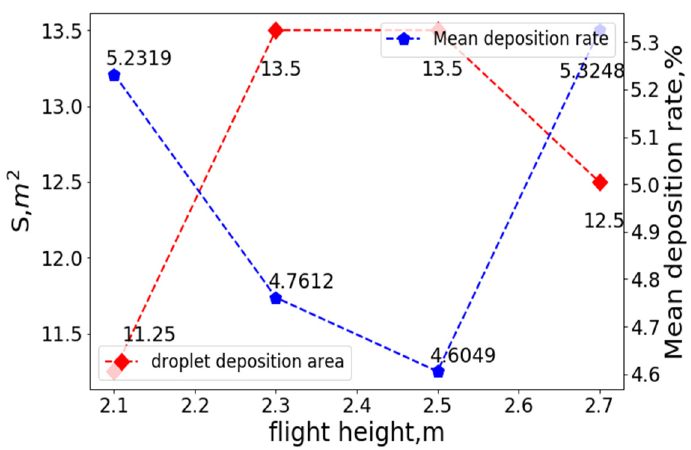
Figure 18. The variation curves of the coverage area, S, and mean droplet deposition rate at a cross- wind speed of 0 m/s, flight speed of 0 m/s, and different flight heights. crosswind speed of 0 m/s, flight speed of 0 m/s, and different flight